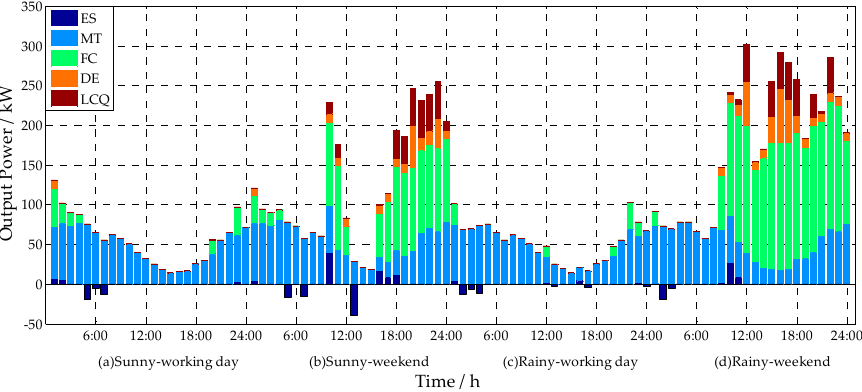
Figure 8. The dispatch optimization results for MG in each period for four scenarios; LCQ: load cut quantity.